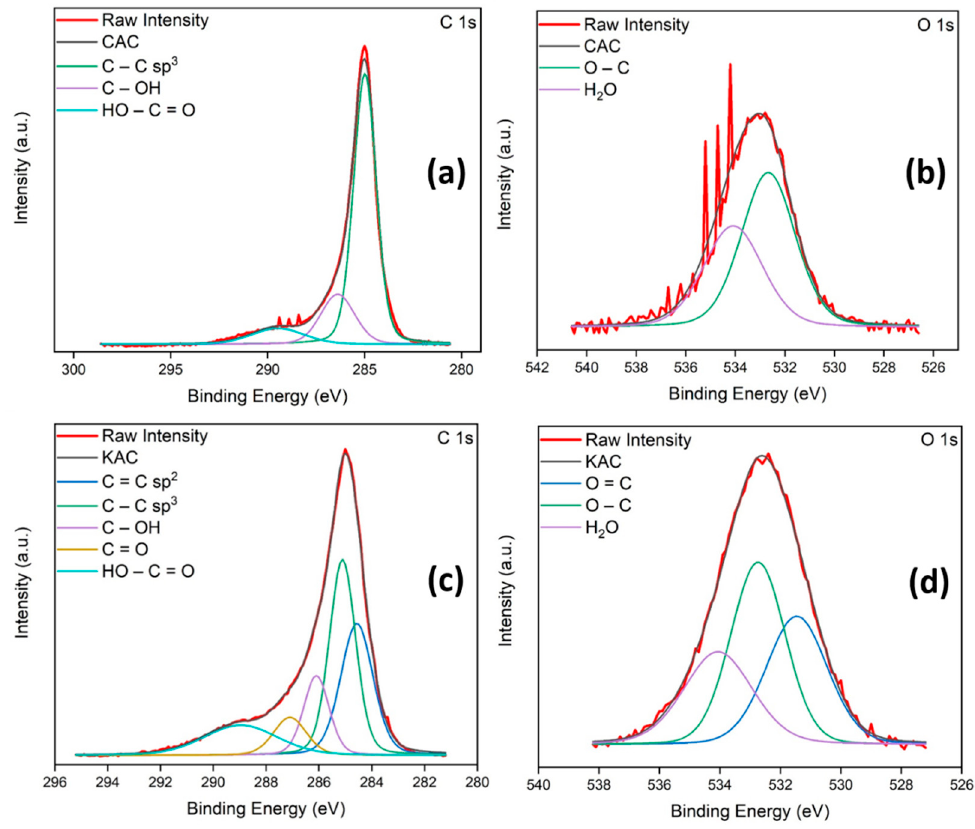
Figure 3. C(1s) and O(1s) XPS spectra of CAC ( a , b ) and KAC ( c , d ).